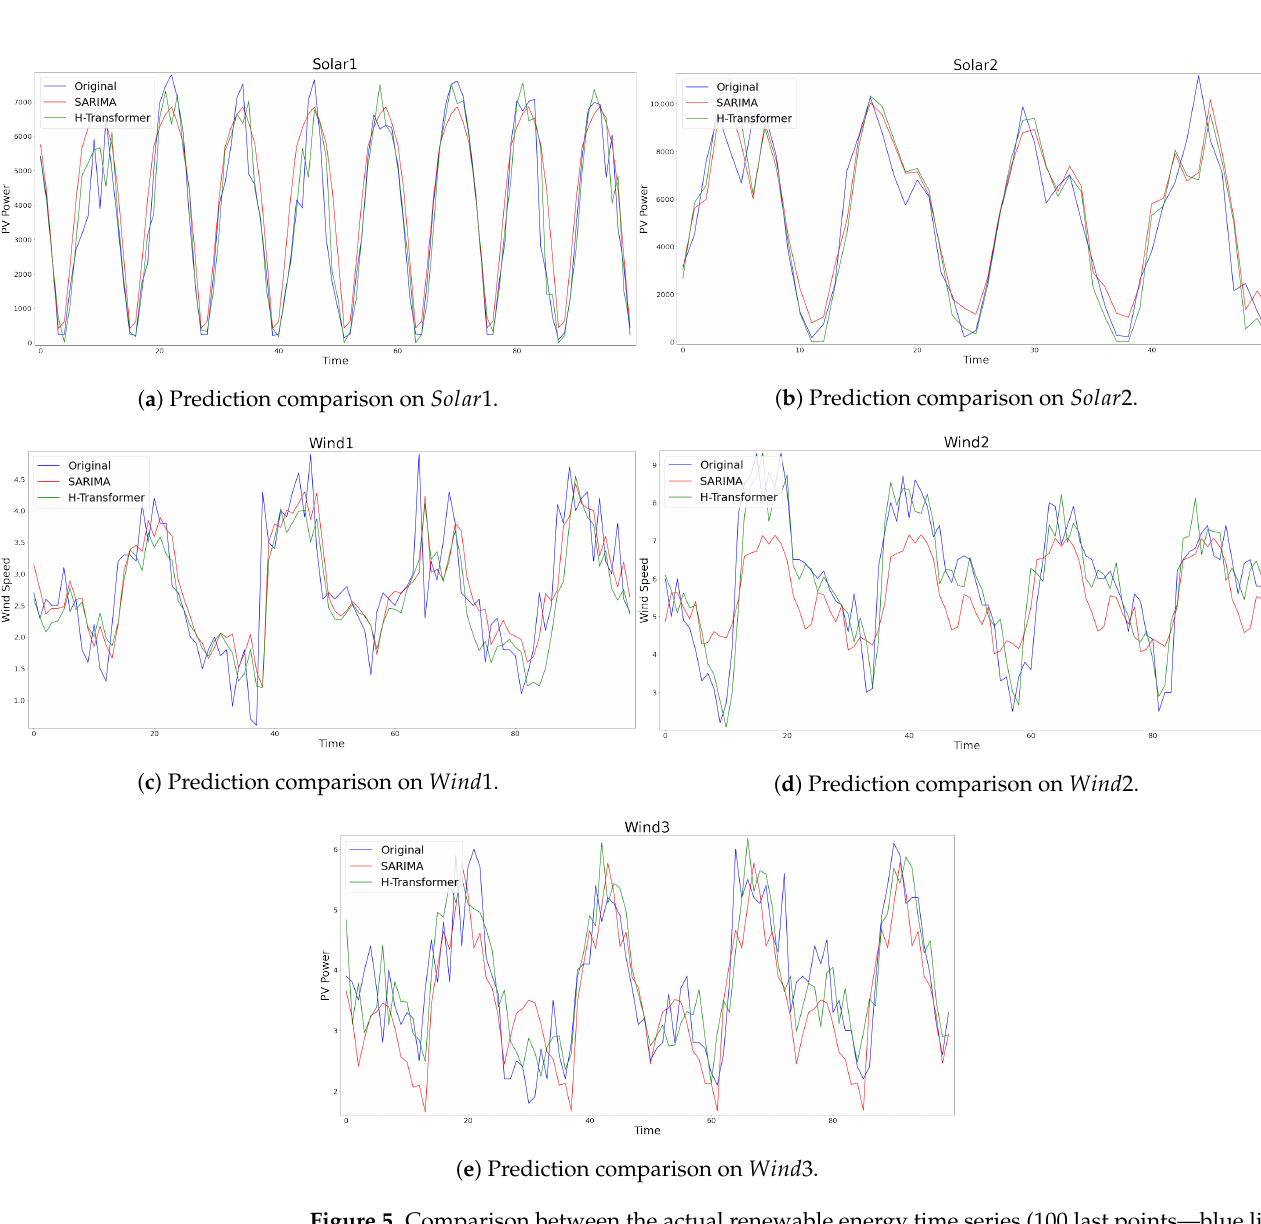
Figure 5. Comparison between the actual renewable energy time series (100 last points—blue line) and the forecasts of SARIMA (red line) and the H-Transformer (green line). Solar dataset predictions are measured in KWh, and Wind dataset predictions are measured in m/s. Table 4. CV(RMSE) performance metric of the H-Transformer, single and hybrid approaches for renewable time series. The best value for each time series is highlighted in